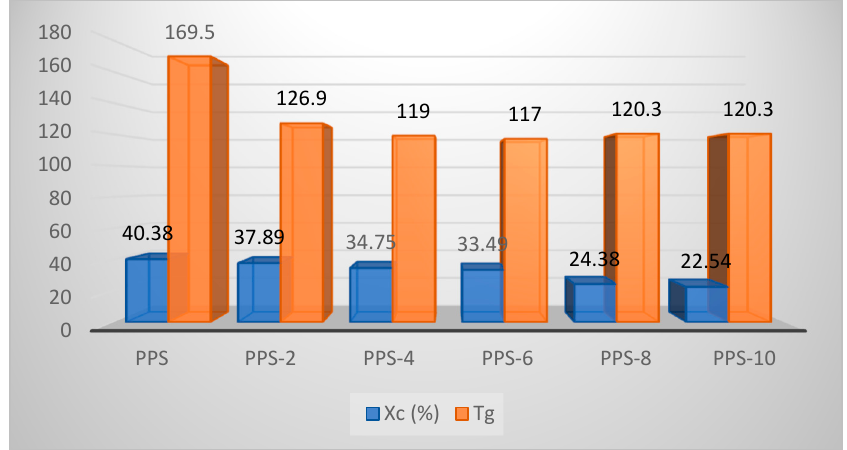
Figure 13. Comparison of the degree of crystallinity and glass transition temperatures of